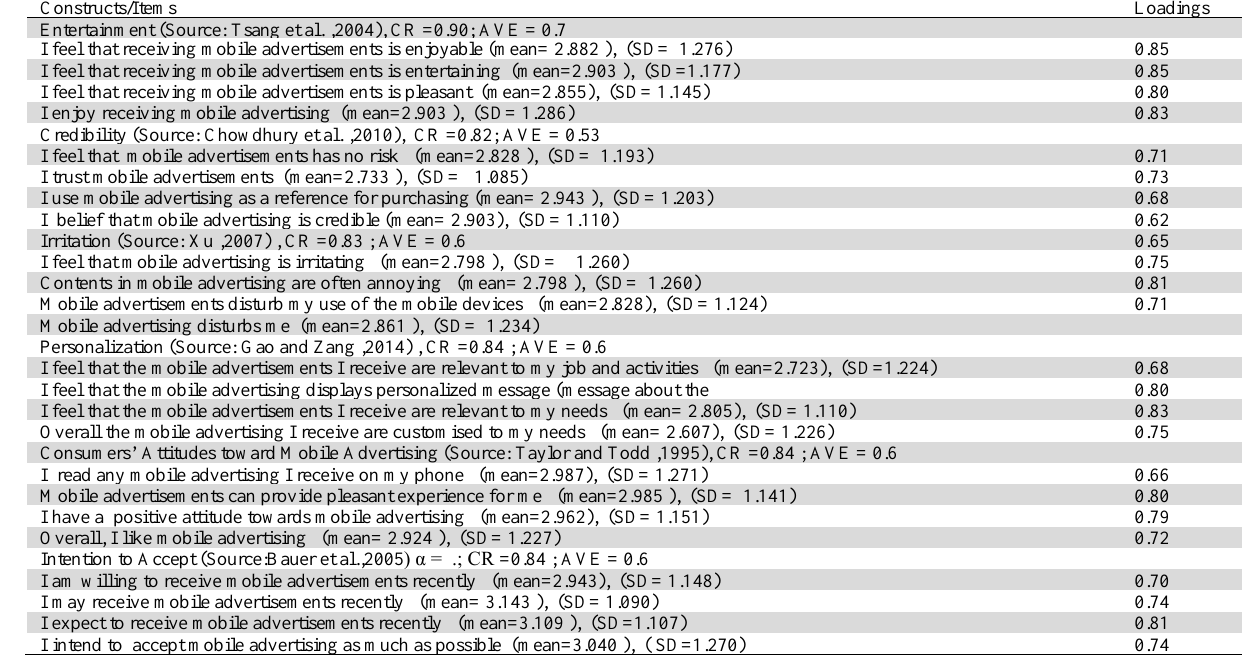
Reliability, Validity, Mean, Standard Deviation